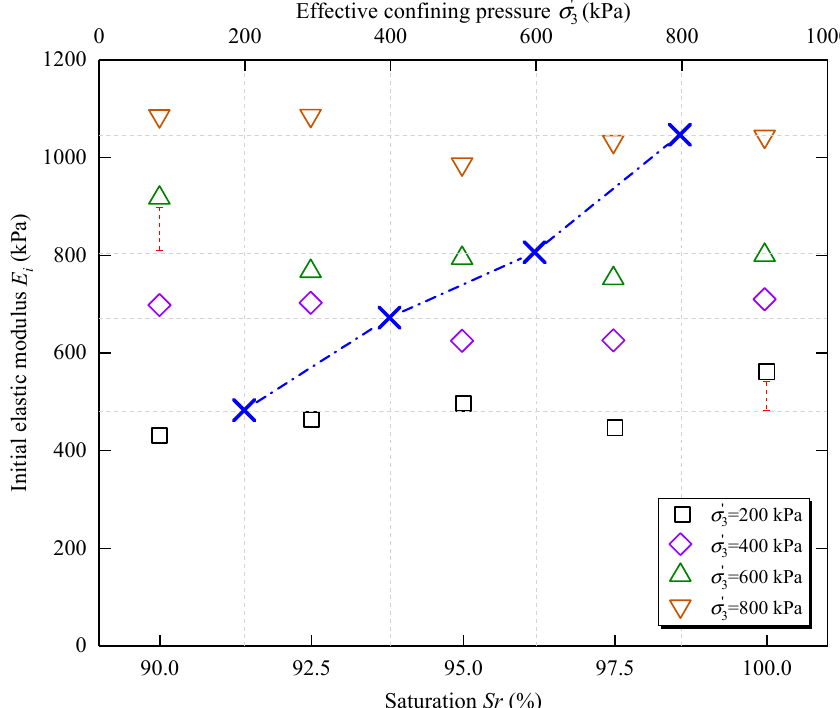
Figure 9. Relationship among initial elastic modulus, effective confining pressure and saturation of coral sand.